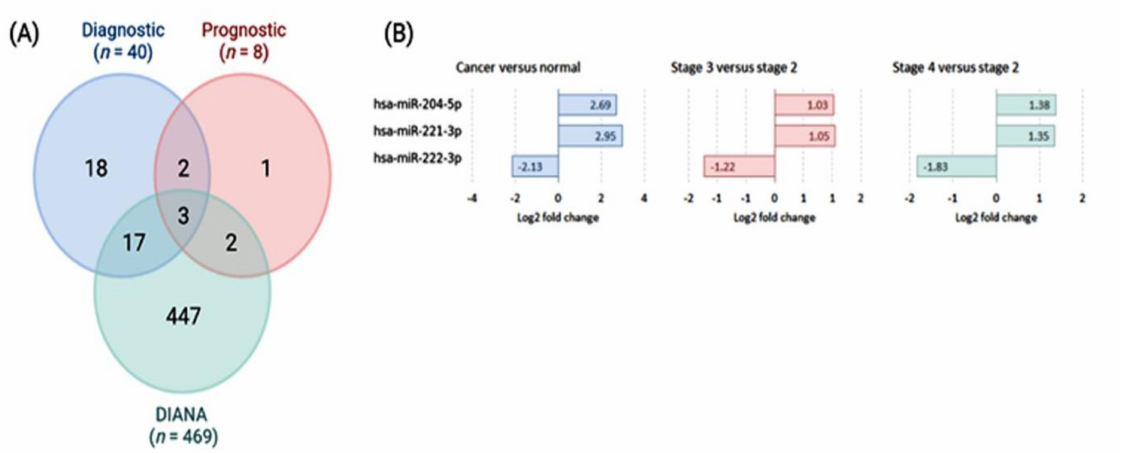
Figure 2. Schemes selection of candidates for poor prognostic miRNAs in thyroid cancer. ( A ) Venn diagram showing the intersection between putative diagnostic and prognostic miRNA biomarkers identified by meta-profiling of transcriptomic signature of high-throughput experiments [data source: dbDEMC (https://www.biosino.org/dbDEMC/index) (accessed on 20 May 2021) and miRNAs targeting genes in thyroid cancer KEGG pathway [data source: DIANA-miRPath v.3.0 (http://www.miRNA.gr/miRPathv2) (accessed on 20 May 2021)]. ( B ) Expression profile of significant miRNAs of thyroid cancer tissues in high-throughput experiments (TCGA and microarray).